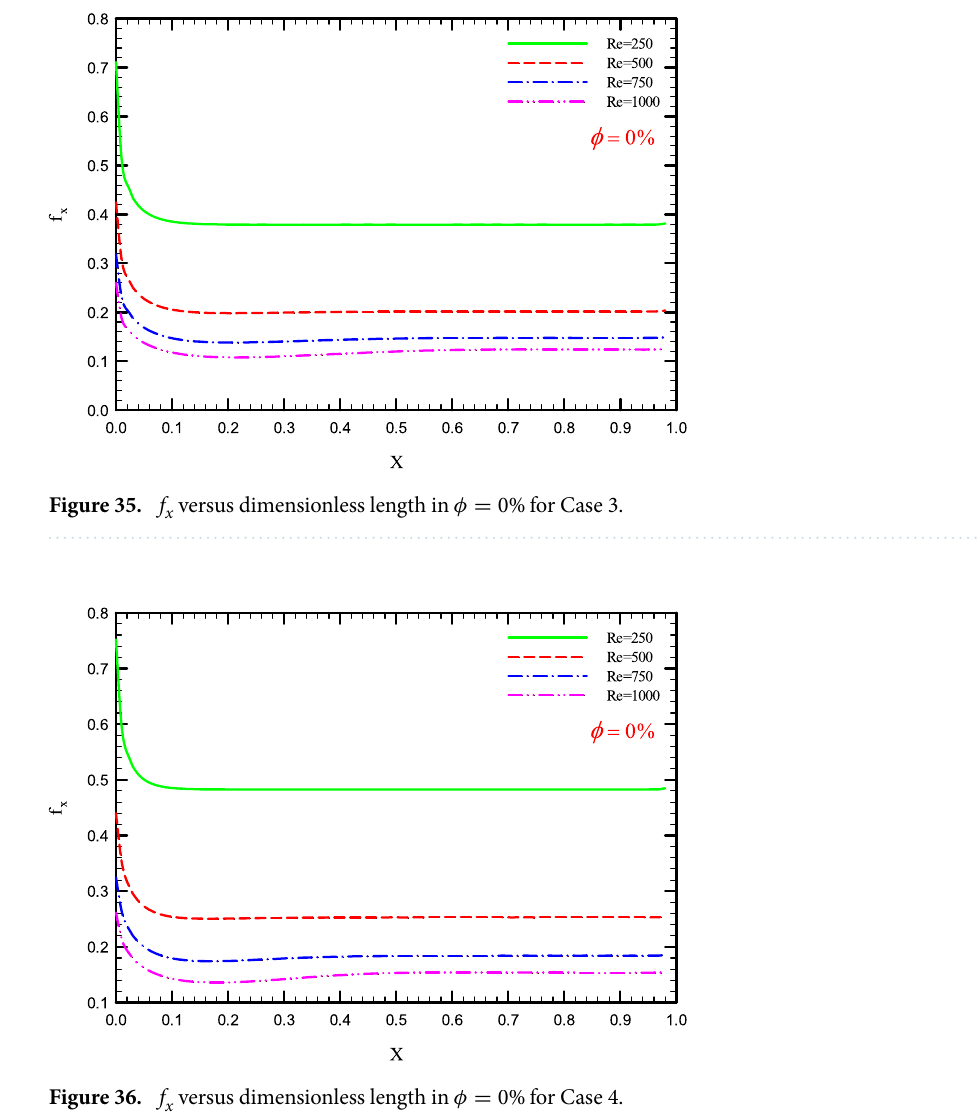
Figure 36. f x versus dimensionless length in φ = 0% for Case 4.